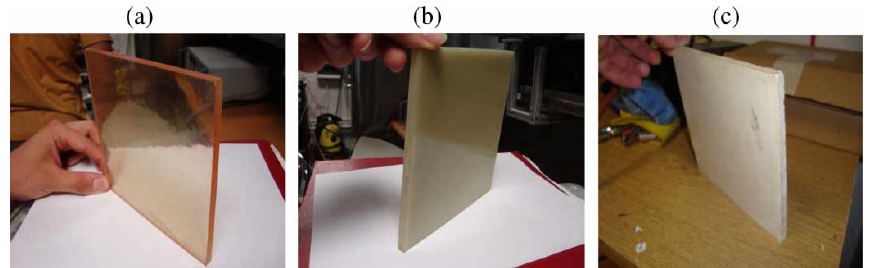
Fig. 1. Polyester samples applied for studies: (a) unmodified sample; (b) sample modified with MoO 3 ; and (c) sample modified with Sb 2 O 3